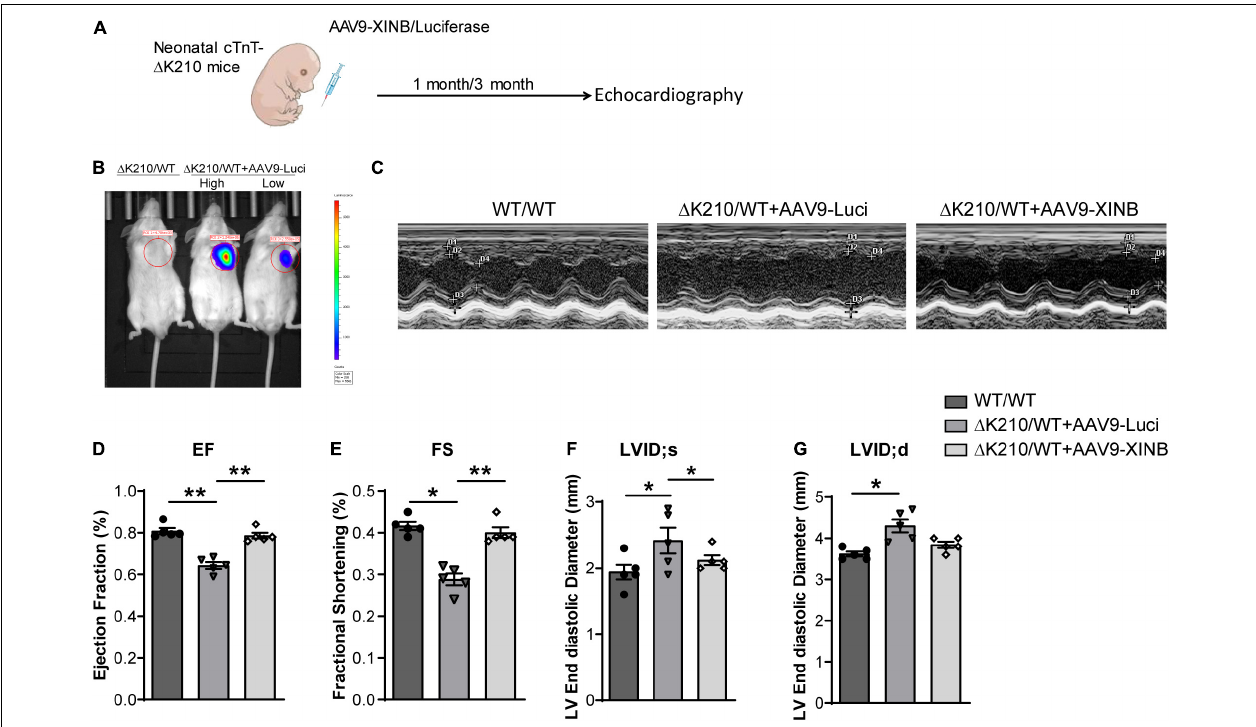
FIGURE 5 | Cardiac-specific expression of XINB improved cardiac function of TNNT2 - (cid:49) K210 mice. (A) Schematic illustration of the design of XINB delivery through AAV9. (B) In vivo bioluminescence imaging of mice tested the efficiencies of AAV9-Luci with the cTnT promoter for cardiomyocyte-specific gene expression. 3-day-old neonatal mice were intraperitoneally injected with AAV9-Luci viruses (1 × 10 12 viral genomes per mouse). Mouses without AAV injection were used as control. High: high dose. Low: low dose. (C) Representative M-mode echocardiography recordings of 3-months-old WT mice, AAV9-Luci injected TNNT2 - (cid:49) K210 mice, and AAV9-XINB injected TNNT2 - (cid:49) K210 mice. (D) Echocardiographic analysis of ejection fraction (EF), (E) fractional shortening (FS), (F) left ventricular end systolic internal diameter (LVID; s), and (G) left ventricular end diastolic internal diameter (LVID; d) of TNNT2 - (cid:49) K210 mice after XINB treatment ( n = 5 per group). Data are represented as mean ± SEM. *P < 0.05, **P <